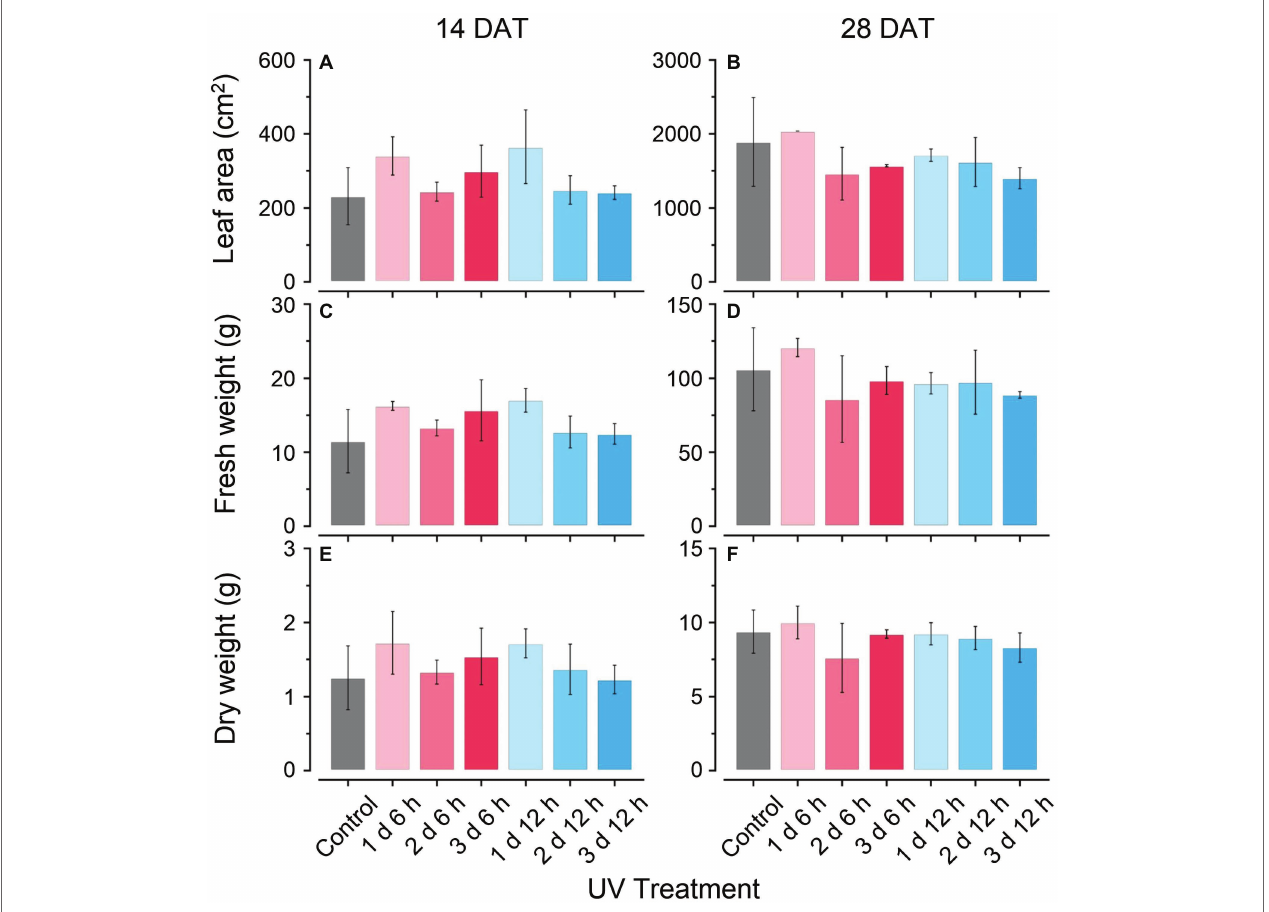
levels increased with plant height and leaf position in the order of upper, middle, and lower leaves for both growth stages ( Figure 4 ). Plants at 14 DAT had lower plant heights but the leaves at each position received higher light intensities compared to those at 28 DAT ( Figure 4A ). At 14 DAT, the absorbed UV levels of the upper leaves were 12.1 and 54.5% higher than those of the middle and lower leaves, respectively ( Figure 4B ). The differences in absorbed UV light between leaf positions were more pronounced at 28 DAT, for which the UV radiation interceptions of the upper leaves were 34.1 and 88.8% higher than those of the middle and lower leaves,